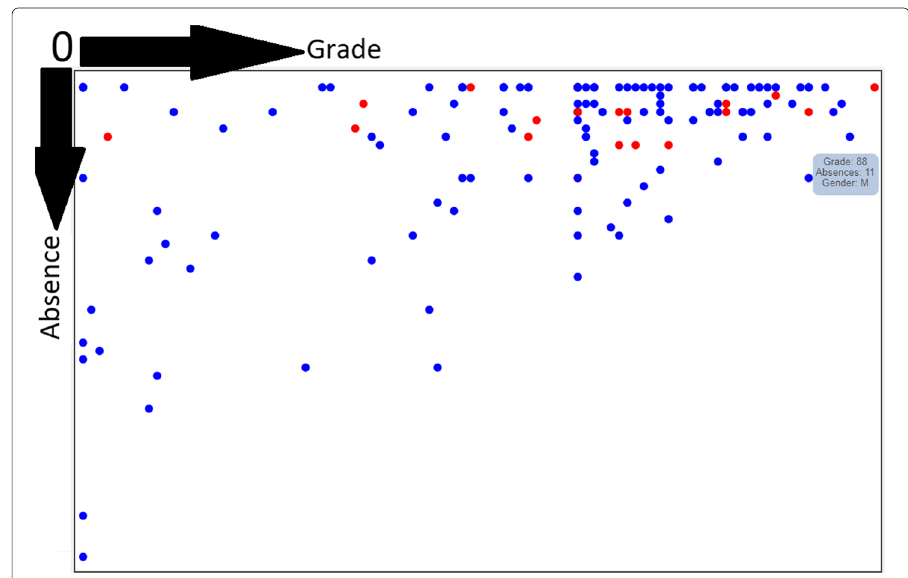
Fig. 3 Scatter plot for "Algorithms and Programming I" subject shows an outlier represented by a student with 11 absences and grade of 88. The pattern shows in general that students with less than two absences received higher